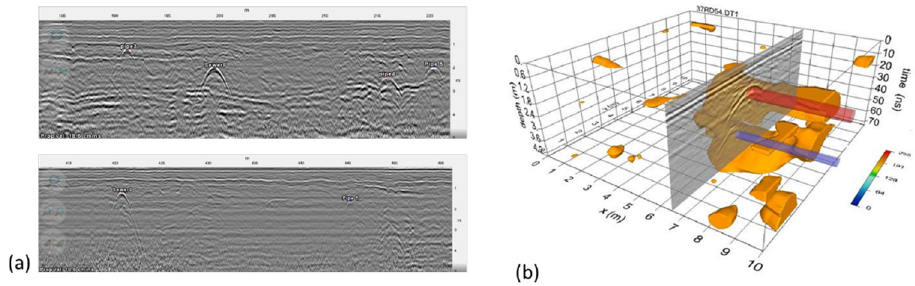
Figure 5. ( a ) 2D electromagnetic scan processing; ( b ) 3D visual processing and interpretation.